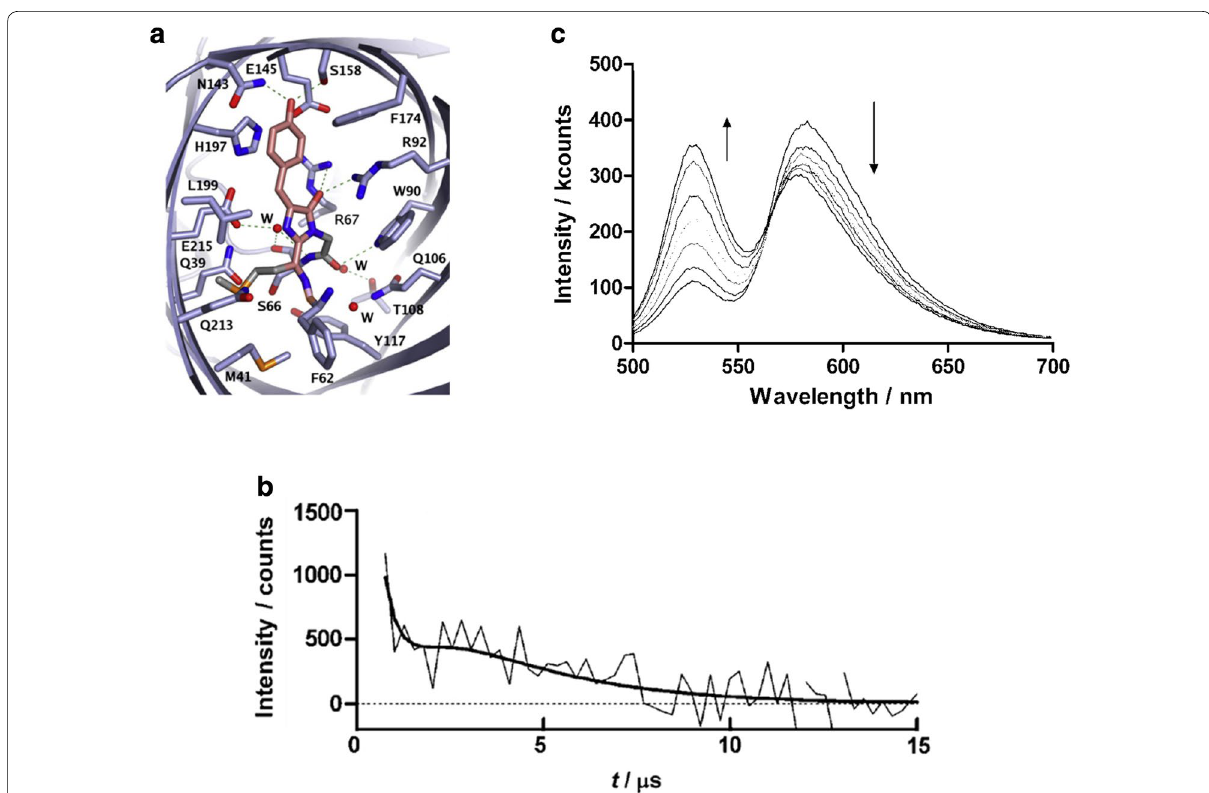
Fig. 8 a Chromophore and their environment in TagRFP (Reproduced from [97] with the permission of Elsevier). The chromophore backbone for TagRFP is shown in orange. The hydrogen bonds are indicated with the green dashed lines, the atoms are colored by the atom type, and the water molecules are shown as the red spheres. b , c Detection of 1 O 2 photogenerated from TagRFP (Reproduced from [70] with the permission of John Wiley and Sons). b 1 O 2 phosphorescence photosensitized by TagRFP in a PBS:Glycerol:d‑PBS mixture (1:1:20) upon irradiation at λ ex 532 nm. The = luminescence signal at λ 1270 nm was fit with a triexponential function. c Time course of fluorescent spectra of optically matched solutions of = SOSG (λ ex 480 nm) and TagRFP under light irradiation at λ ex 532 nm. The increased amount of 1 O 2 was detected by the increase in the SOSG = = band (λ em 527 nm) with irradiation at λ ex 532 nm. The concomitant decrease in the TagRFP band (λ em 590 nm) indicated photobleaching and/ = = = or